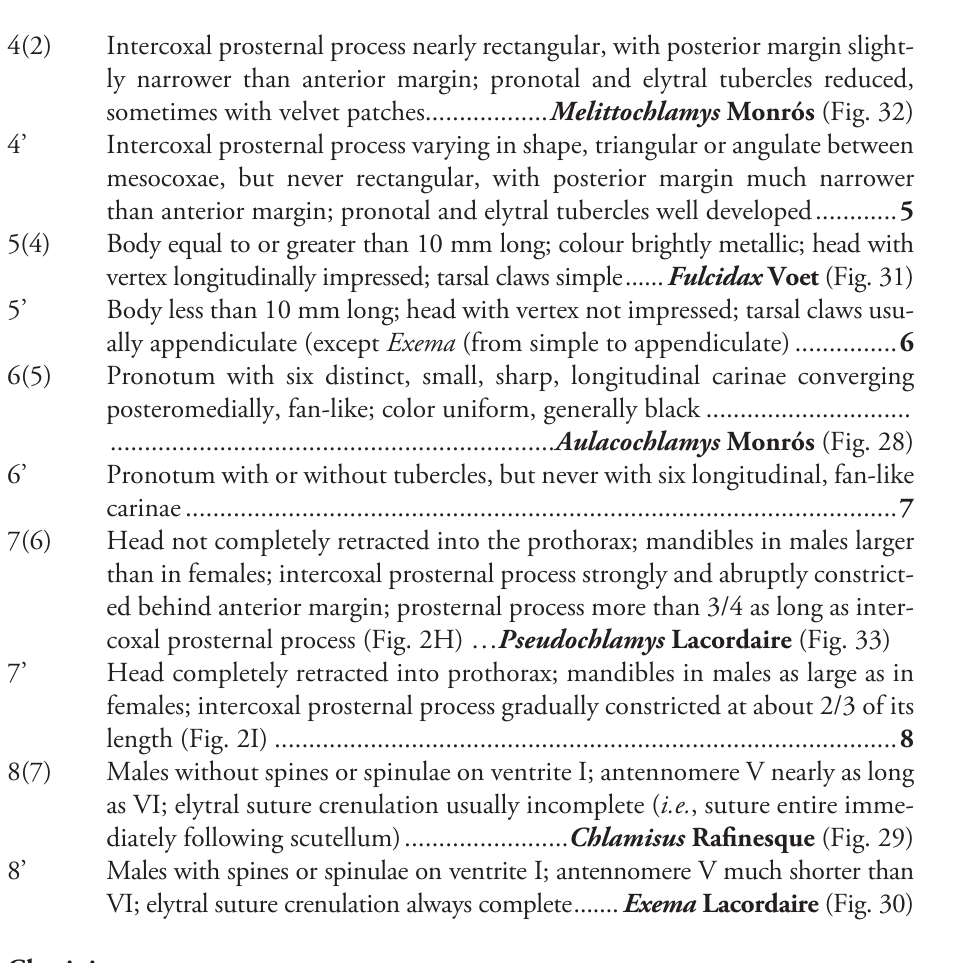
Prothorax with lateral antennal grooves on hypomeron Ischiopachina Chapuis (Monotypic subtribe). Elytra without strong parallel longitudinal